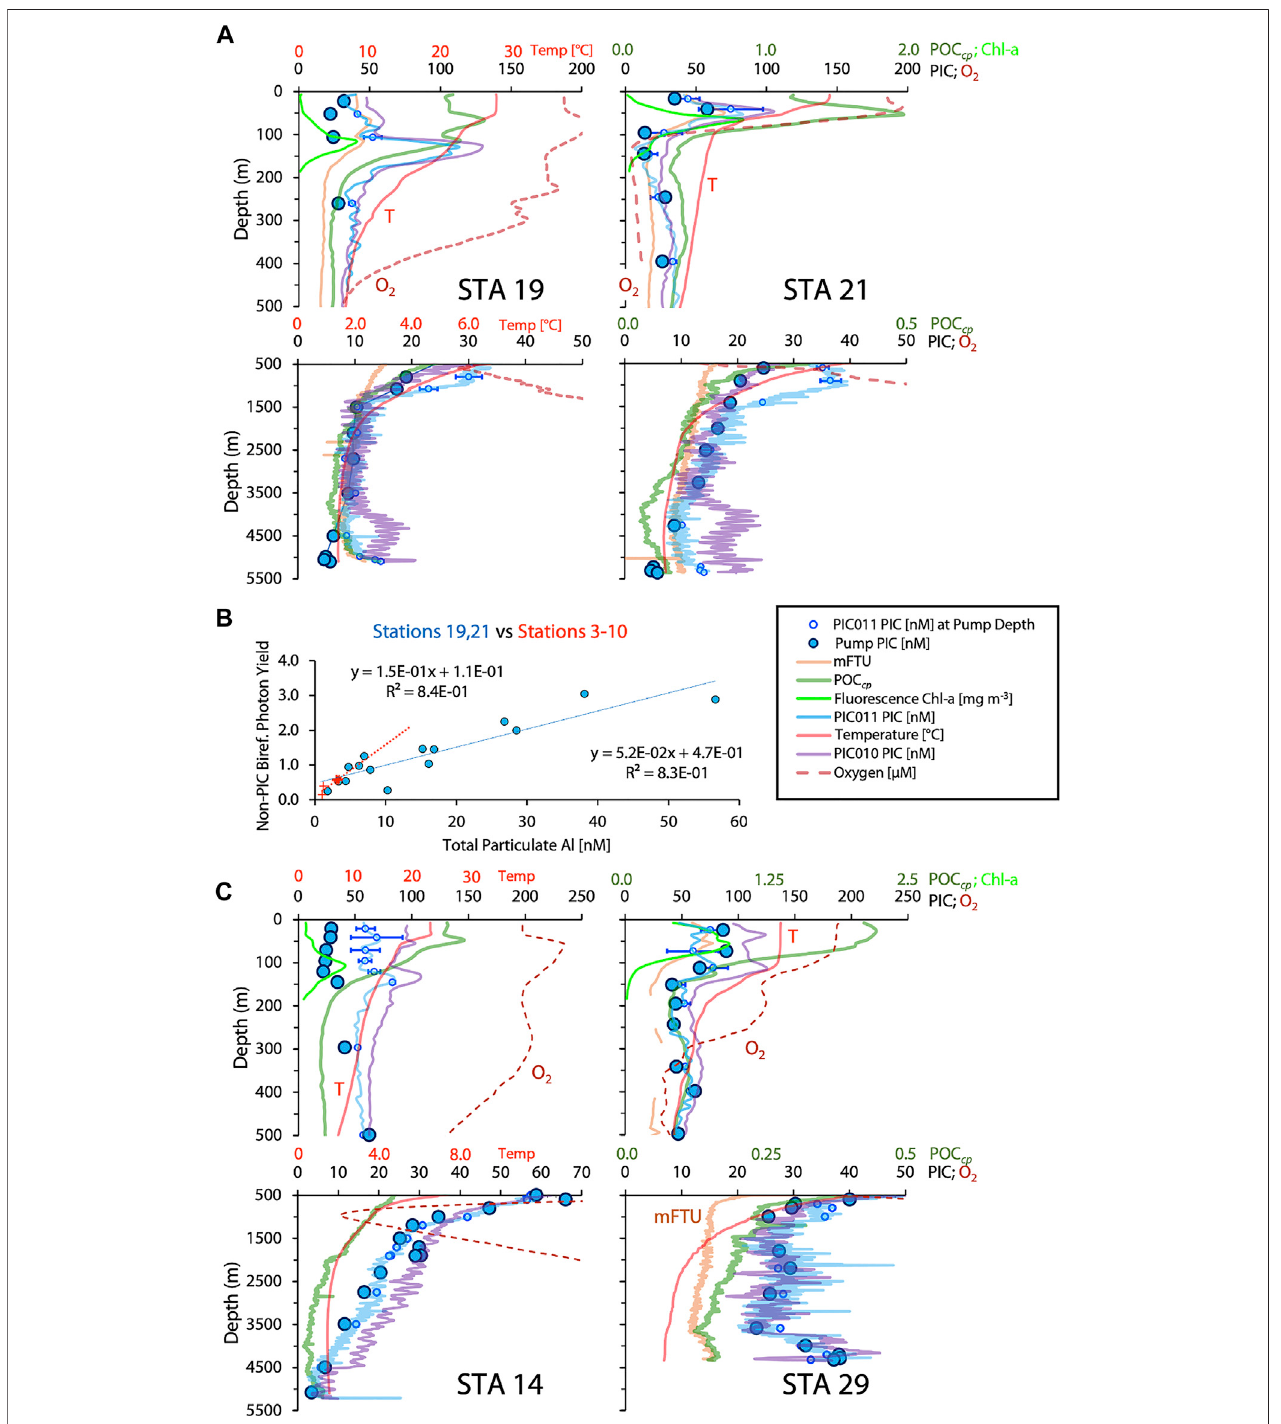
FIGURE 10 | (A) Stations 19 and 21 pro fi le data for birefringent photon yield converted to PIC from sensors PIC010 and PIC011 are shown with measured PIC values. Also shown are chlorophyll fl uorescence, turbidity, POC calculated from beam attenuation coef fi cient, oxygen, and temperature. Upper panel is an expanded 0 – 500 m interval; the lower panel shows 500 m to the sea fl oor. Lowest PIC concentrations were found in strongly oxygen de fi cient waters the upper water column at station 21. The sharp peak near 120 m at station 19 is reproduced by both sensors and was not sampled by the pumps. The sensor PIC diverges from pump PIC within 1000 m of the sea fl oor which we infer is due to resuspended clay particles. (B) Regression of non-PIC birefringent photon yield versus particulate aluminum contrasts stations 19 and 21 with Stations 3 to 10. The latter stations are found in a sedimentary regime dominated by chlorite clays. Stations 19 and 21 are in a regime dominated by illite clays (Grif fi n, Windom, and Goldberg; 1968). (C) Data from stations 14 and 29, where sensors and measured PIC covary strongly from 500 m to the sea fl oor. In the upper 150m of the water column at station 14, both sensors indicate higher PIC levels than measured. At station 29, both sensors agree with measured PIC throughout the entire water